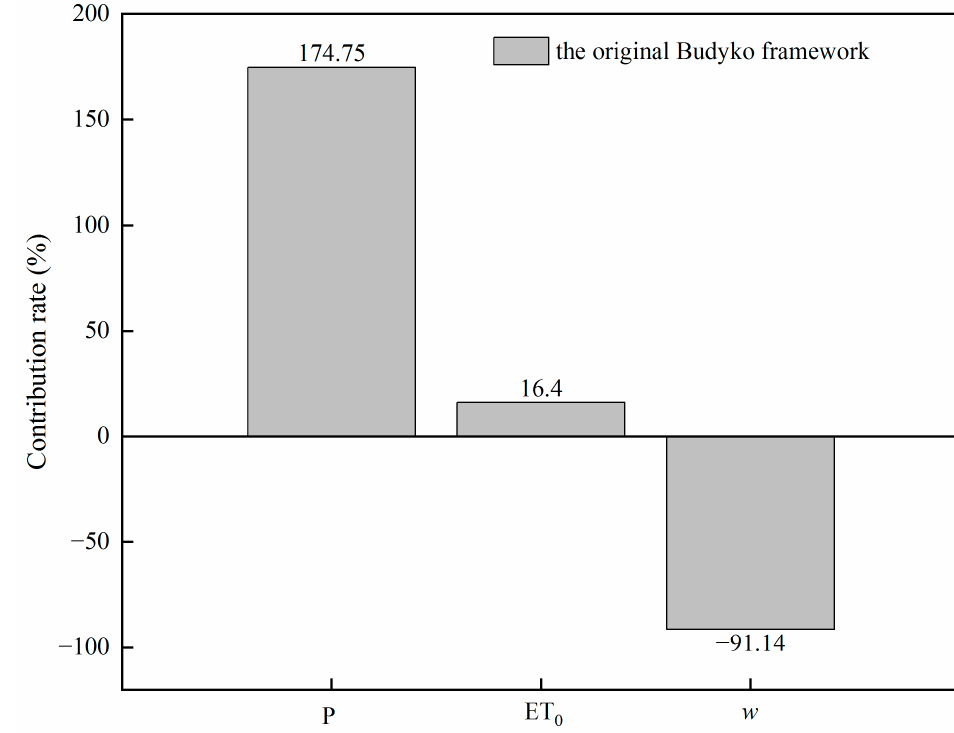
Figure 7. Contribution rate of the variation in P, ET 0 , and w to ET variation.